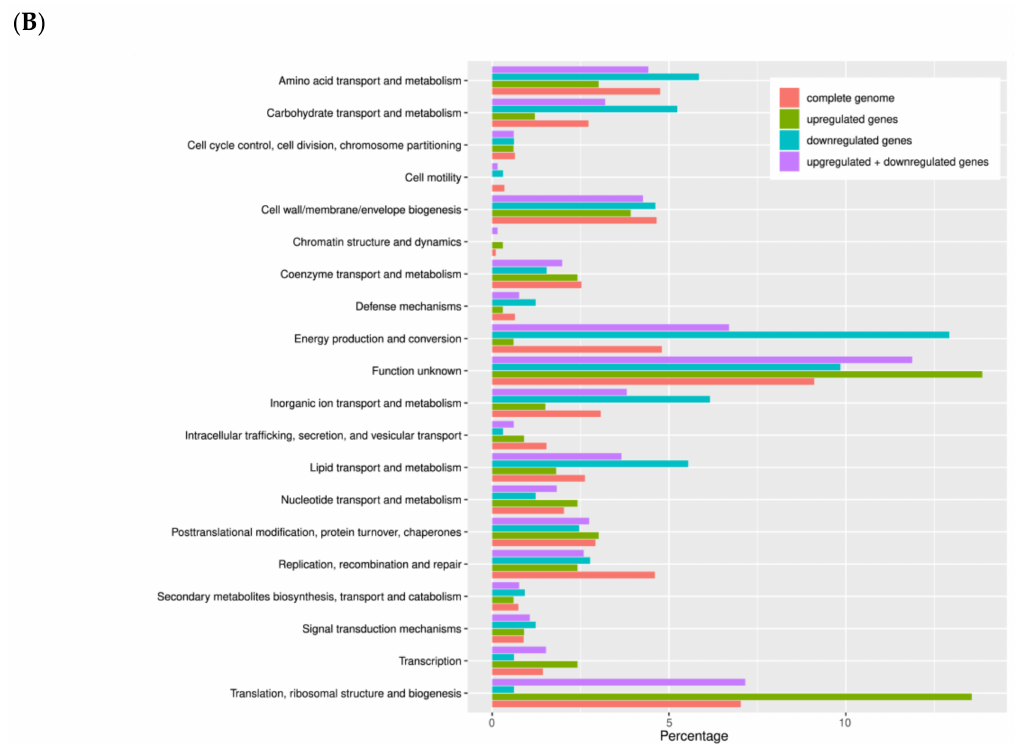
Figure 4. Analysis of di ff erentially expressed genes (BPDL vs. untreated RBs) by functional COG categories. ( A ) The list shows for each COG category: the number of genes (annotated on W. chondrophila genome) belonging to the given COG category (All); the number of genes up-regulated by BPDL treatment (Up); the number of genes down-regulated by BPDL treatment (Down); the number of genes up- or down-regulated (Up + down). As the same gene can be assigned to more than one COG category, the total number of genes in the last line exceeds that of the genes encoded by W. chondrophila genome. For each number, the fraction (with respect to the total, indicated in the last line) was also calculated. ( B ) The fraction for each COG category shown in A. The graph clearly shows that among the genes up-regulated by BPDL treatment, unknown functions and functions related to translation are over-represented, while energy production, carbohydrate metabolism, amino acid metabolism, inorganic ions transport and metabolism functions are over-represented among genes down-regulated by iron